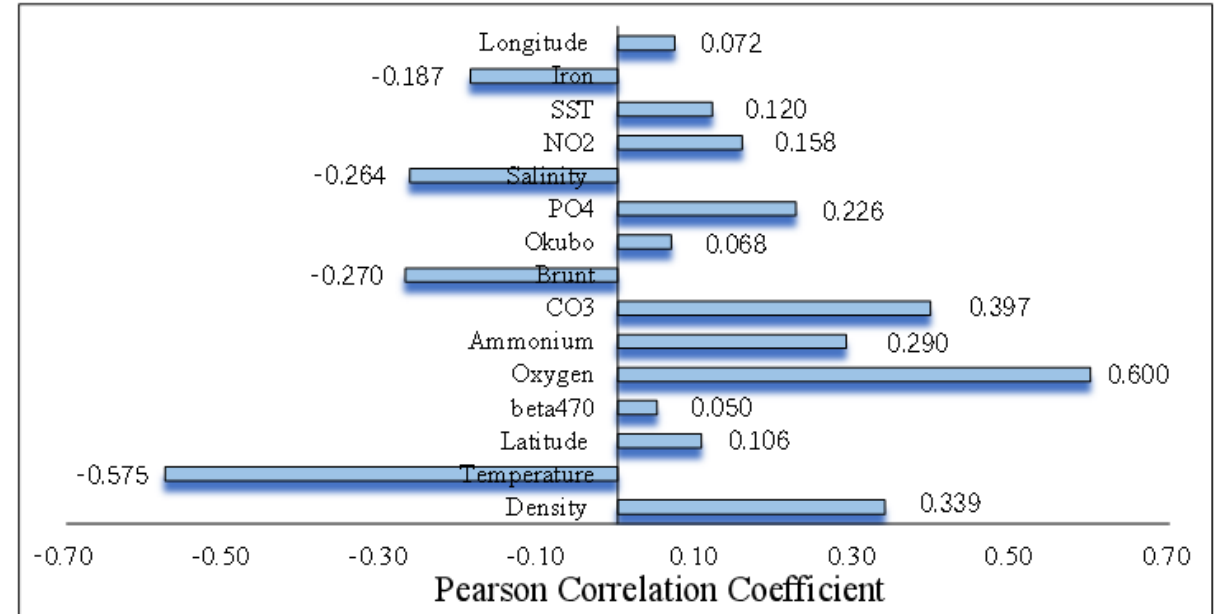
Figure 4. Pearson correlations of the environmental factors and Chl- a abundance. Since the characteristic importance of the environmental factors was normalized, the Pearson correlation coefficients were also normalized. The Pearson correlation coefficient, characteristic importance index, and comprehensive correlation index are presented in Table 3. The histogram of the comprehensive correlation indexes was drawn in Figure 5. As shown in Figure 5 and Table 3, four environmental factors including the temperature, density, oxygen and CO 3 have the greatest influence on the abundance of Chl- a , while the comprehensive correlation indexes of the other factors were relative low. Table 3. Comprehensive correlation